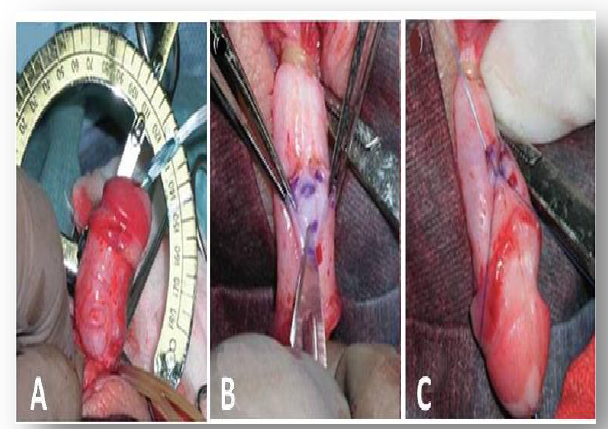
Figure 7: Dorsal plication (A) Artificial erection demonstrates 30-degree curvature. (B)Buck’s fascia is cut longitudinally at the 12 o’clock position (C)